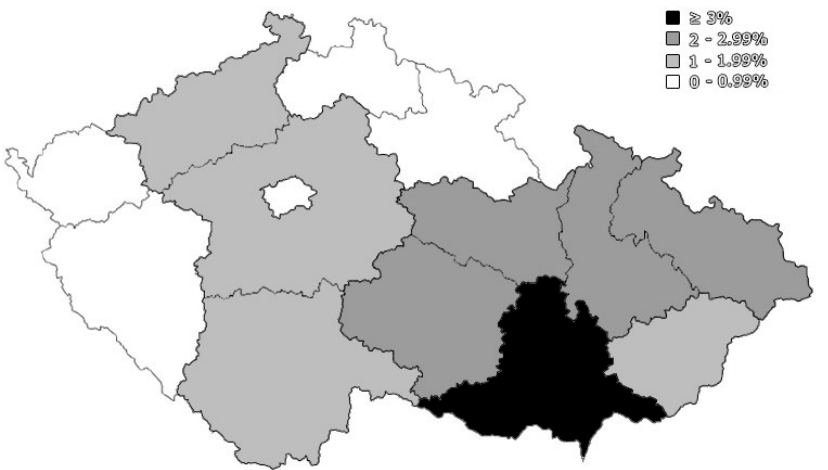
Figure 3. Geographic distribution of participating pregnant and lactating women (PLW), University Hospital Brno, August–October 2021 ( n = 362).